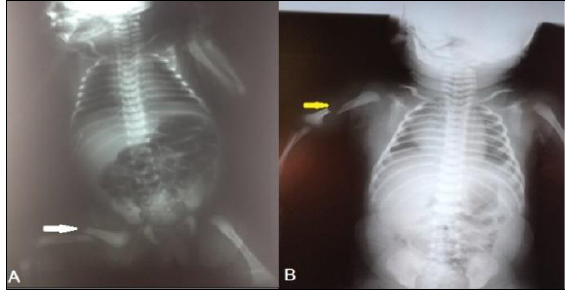
Figure 2: A) Femur fracture (white arrow) in the first case with skeleton injury. B) Humerus fracture (yellow arrow) in the second case of skeleton